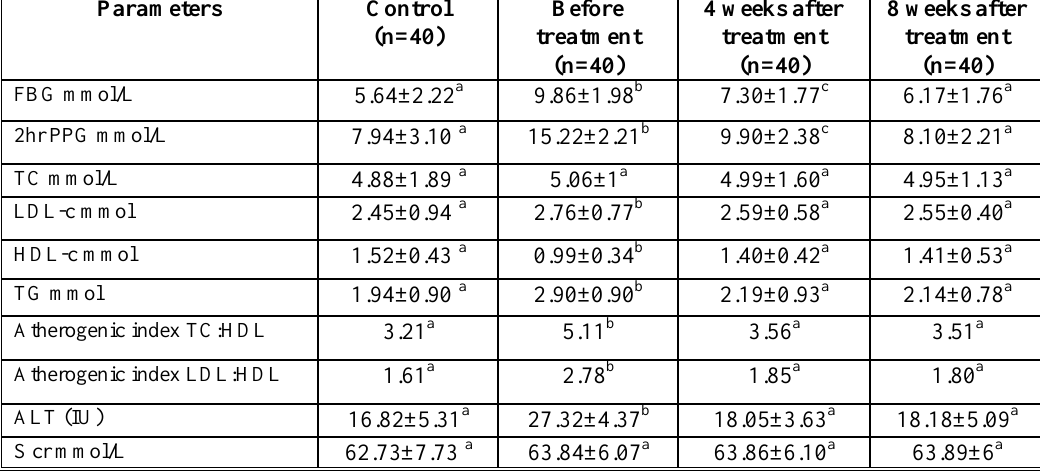
Table 1: Effects of Repaglinide on serum fasting blood glucose, 2hrs postrandial glucose, total cholesterod, Low density lipoprotein cholesteros, high density lipoprotein cholesterol, triglycerides, alanine aminotransferase and serum creatinine after 4 and 8 weeks of